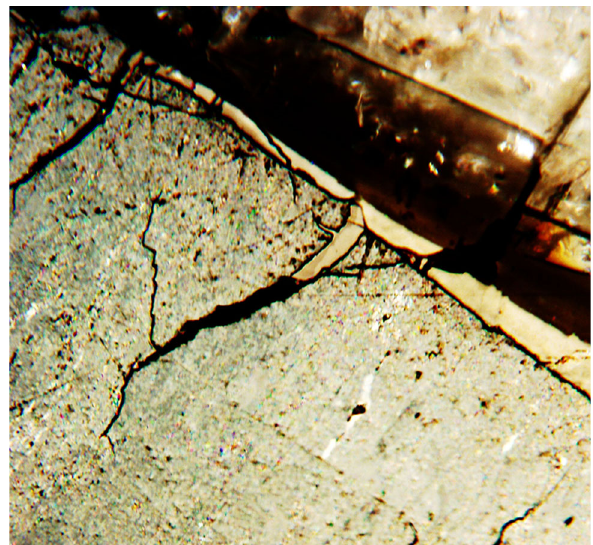
Fig. 18 Porous texture of altered coal from the Kladno mine, Kladno–Rakovnı´k Basin. Contact of carbonate with collotellinite faulted by